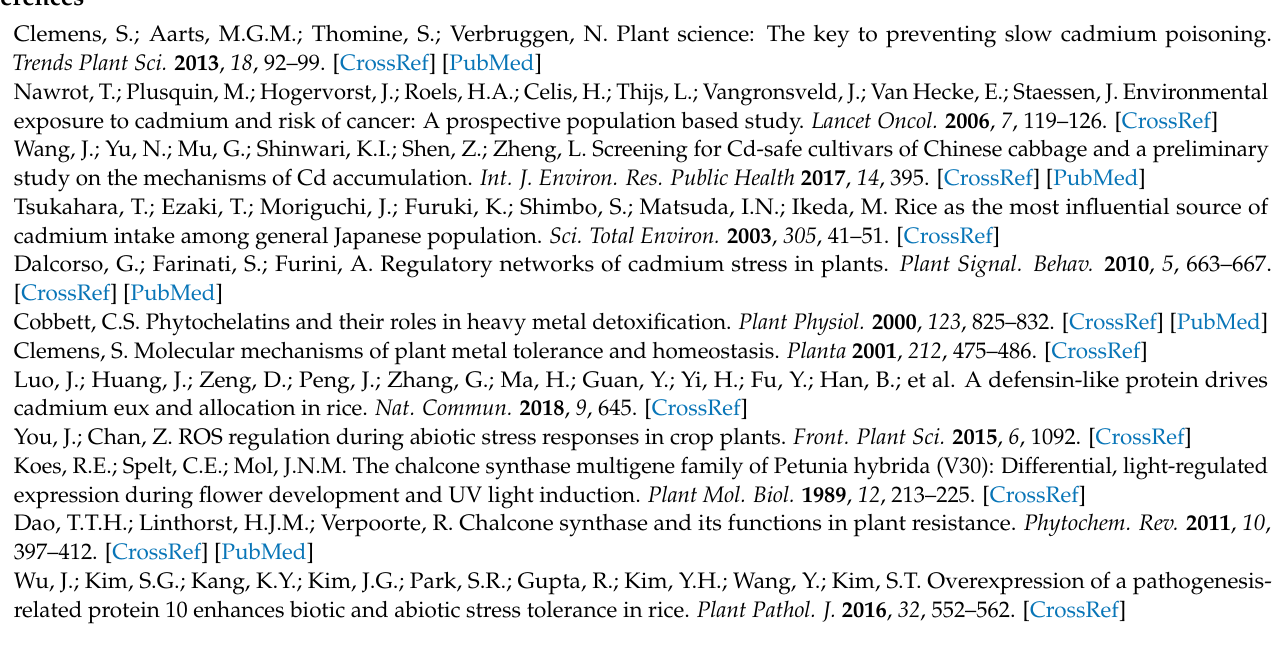
Table S9. Motifs in 6 possible downstream genes of